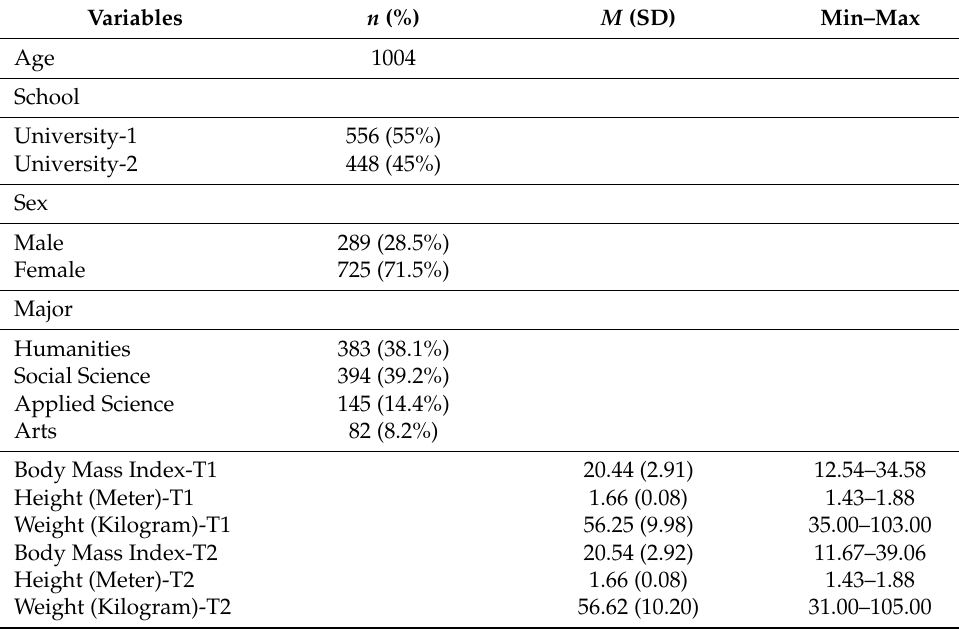
Table 1. Demographic characteristics of the sample ( n =